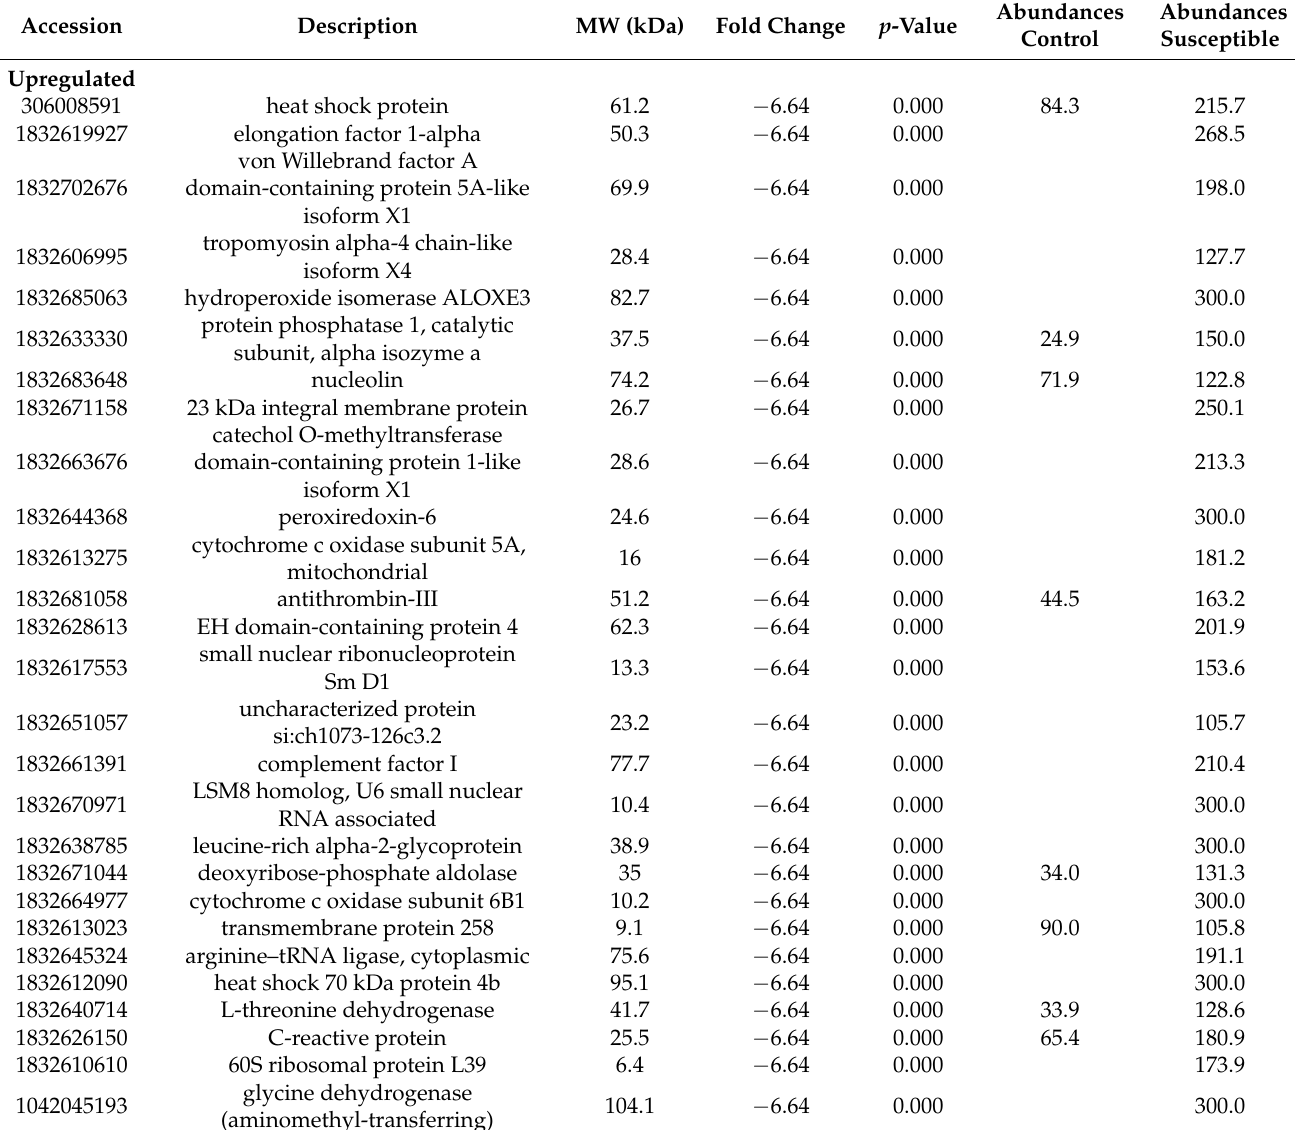
Table 3. Differentially expressed protein was found to be susceptible when compared to the